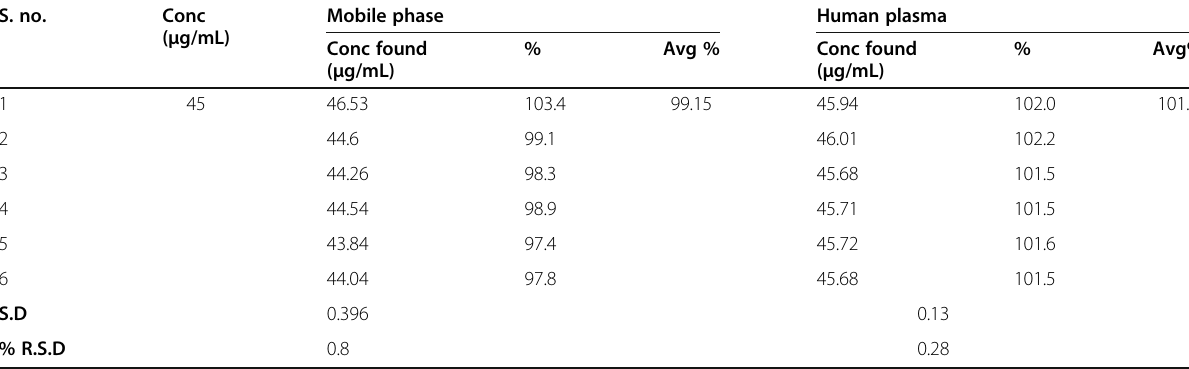
Table 5 Intermediate precision of Ivacaftor in mobile phase and human plasma S. no.